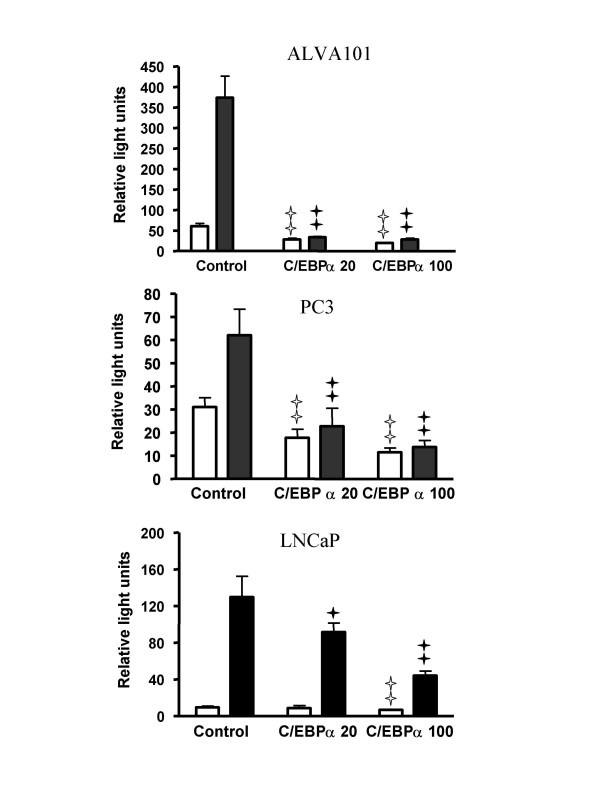
Dose-dependent inhibition by C/EBPα of the activity of PSA promoter/enhancer. Prostate cancer cells, ALVA101, PC3, and LNCaP cells were transiently transfected either with 0, 20, or 100 ng C/EBPα in the presence (dark bars) or absence (open bars) of DHT. Fifty ng of the androgen receptor expression vector (also the kind gift of Dr. Stephen P. Balk) was co-transfected into the AR negative cell lines, ALVA101 and PC3. The results are expressed as in Figure 4A with the double star representing a p-value < 0.01, a single star, p-value < 0.05, and the open and dark stars representing the same comparisons as in Figure 4A.